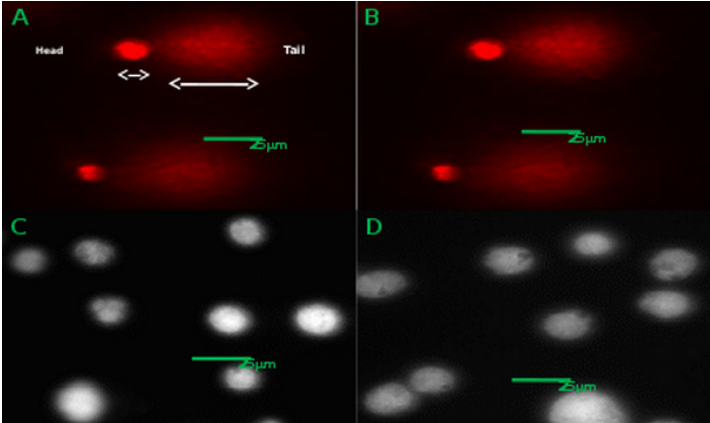
Figure 8. ( A , B ) Comet images of CACO-2 cells after exposure to H 2 O 2 (15 µ g mL − 1 ) and ( C , D ) Images of CACO-2 cells after exposure to SiQDs (200 µ g mL − 1 ) for 24 h using Comet IV (Perceptive, Bury St Edmunds,